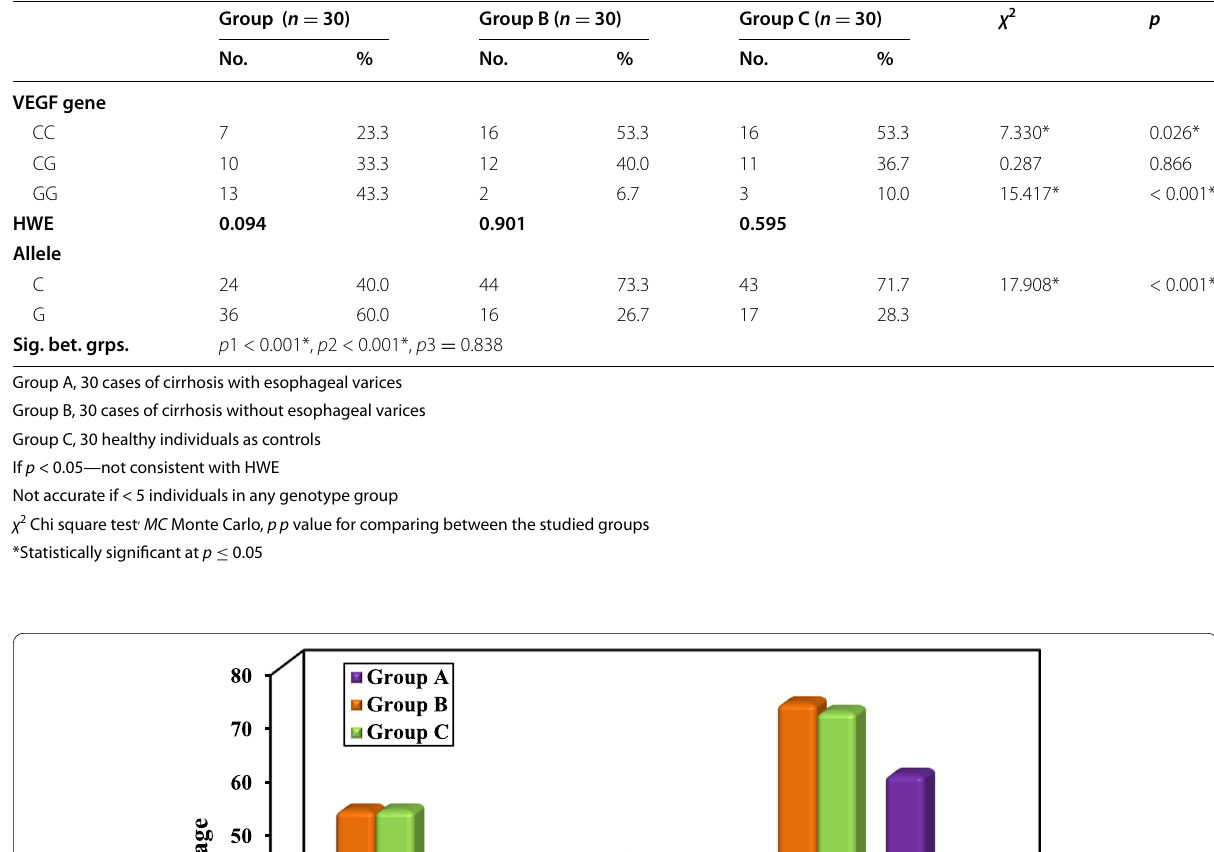
405)G (RS2010963) SNP in the studied groups ( n +